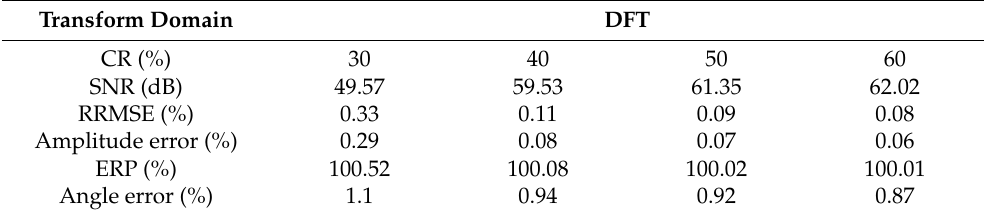
Table 3. Reconstruction results of voltage fluctuation signal in the DFT domain.